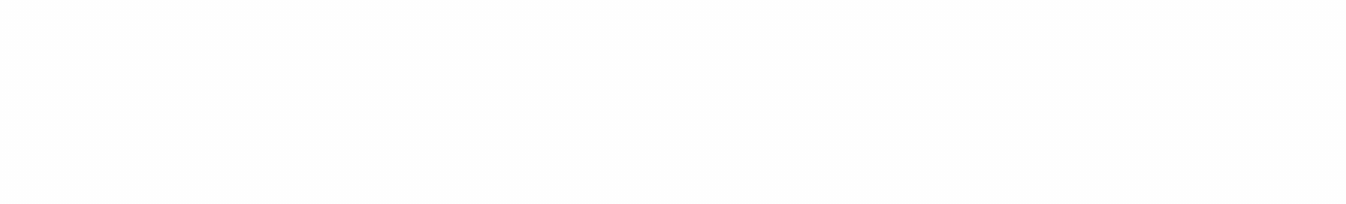
FIGURE 12 Graphical representation of the saddle-node and period-doubling bifurcation parameters for all family of FPs in DSM for two different values of the